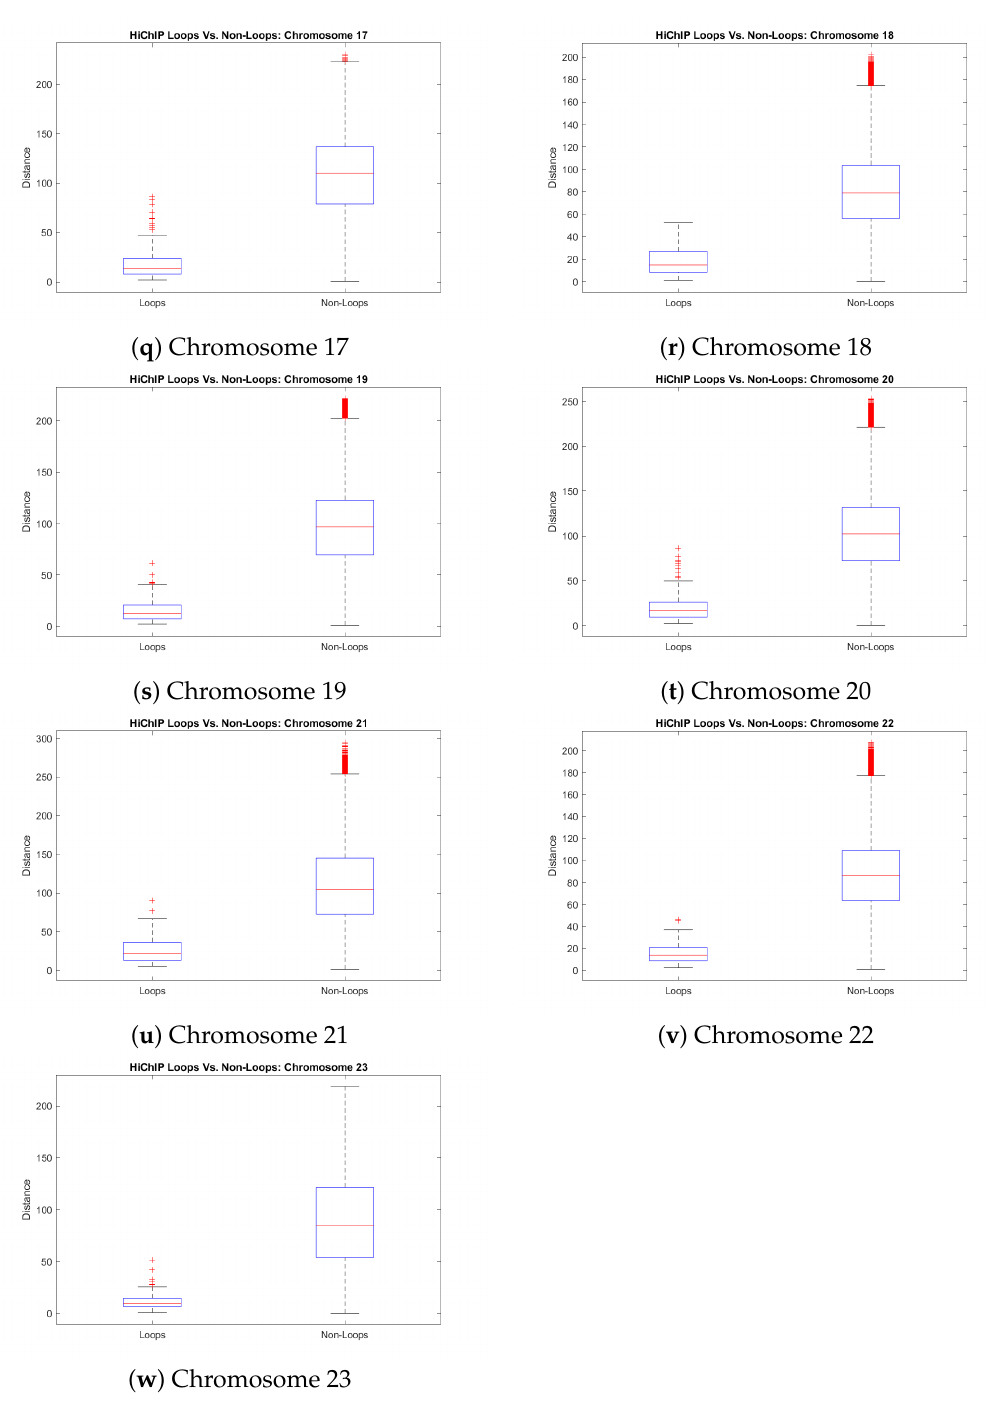
Figure A4. Comparisons of the looped and non-looped distances of CBCR’s outputs at 100kb resolution for the HiChIP